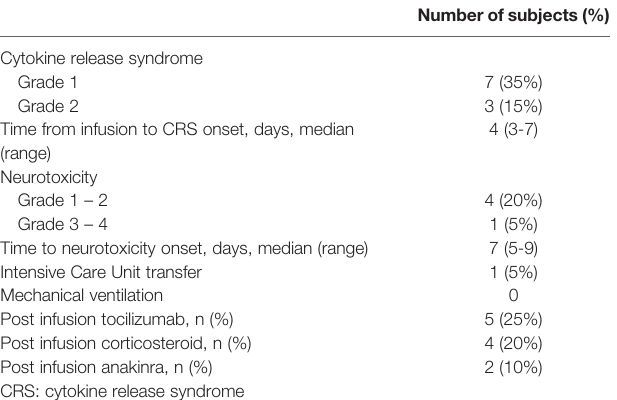
TABLE 3 | Summary of immune effector cell